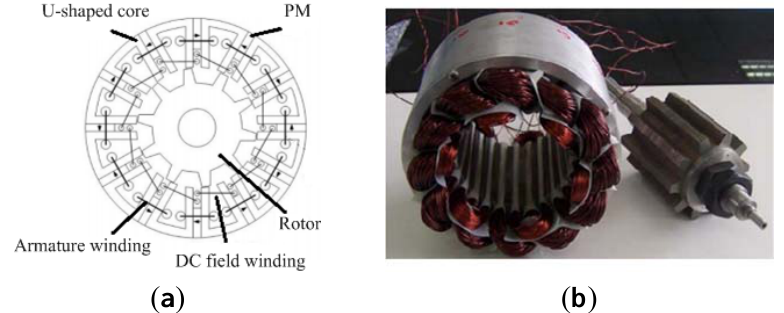
Figure 9. HEFS motor. ( a ) Schematic; ( b )